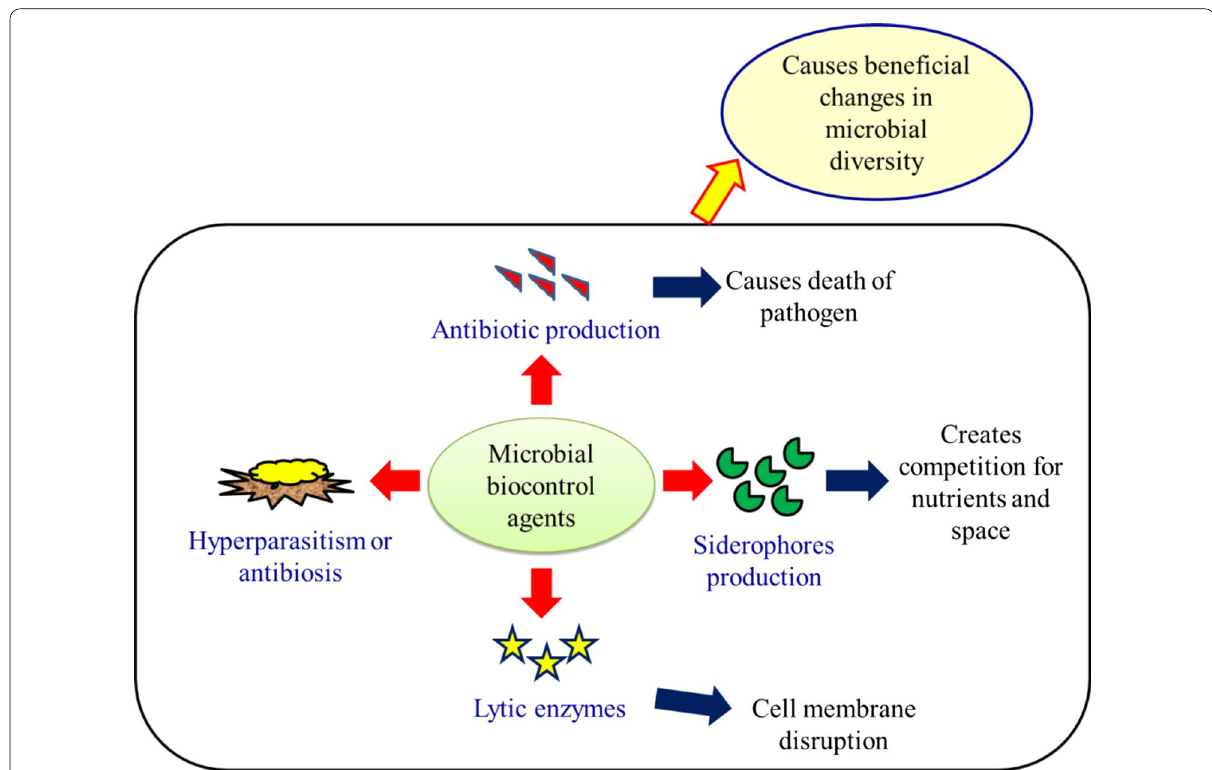
Fig. 2 Various mode of action of microbial biocontrol